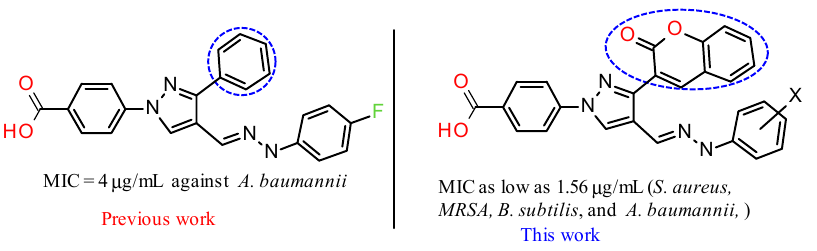
Figure 1. Pyrazole-derived hydrazones as potent antimicrobial agents.